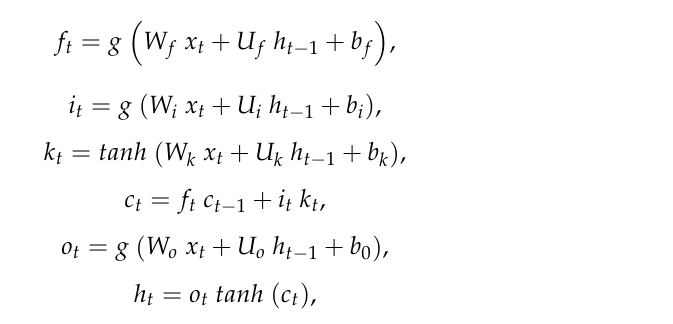
Figure 5. Structure of neural networks with activation function. The most common activation functions are hyperbolic tangent function, sigmoid function, linear function, ReLU (rectified linear unit) function, leaky-ReLU function, softmax function, and swish (a self-gated) function [55,58,59]. In this work, we use the hyperbolic tangent function ( tanh ) as the activation function for our proposed ANN and DNN models. The tanh function is used for the input and hidden layers. In hyperbolic tangent function ( − 1, 1) 𝑓(𝑥) (cid:3404) 𝑡𝑎𝑛ℎ(𝑥) (cid:3404) (𝑒 (cid:3051) (cid:3398) 𝑒 (cid:2879)(cid:3051) ) (𝑒 (cid:3051) (cid:3397) 𝑒 (cid:2879)(cid:3051) ) ,